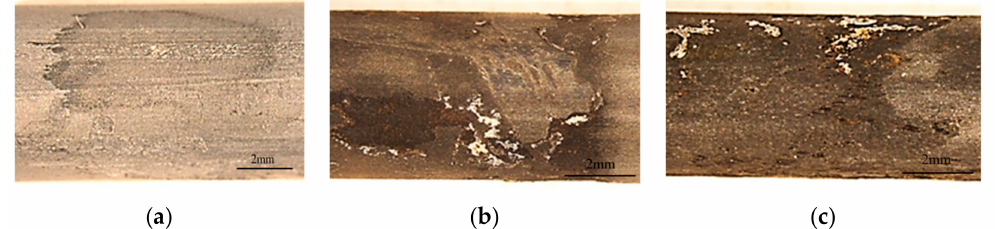
Figure 11. Corrosion patterns of cable-bolt specimens after 300 days, ( a ) groundwater, ( b ) clay with groundwater, and ( c ) mixture of coal and clay with groundwater.